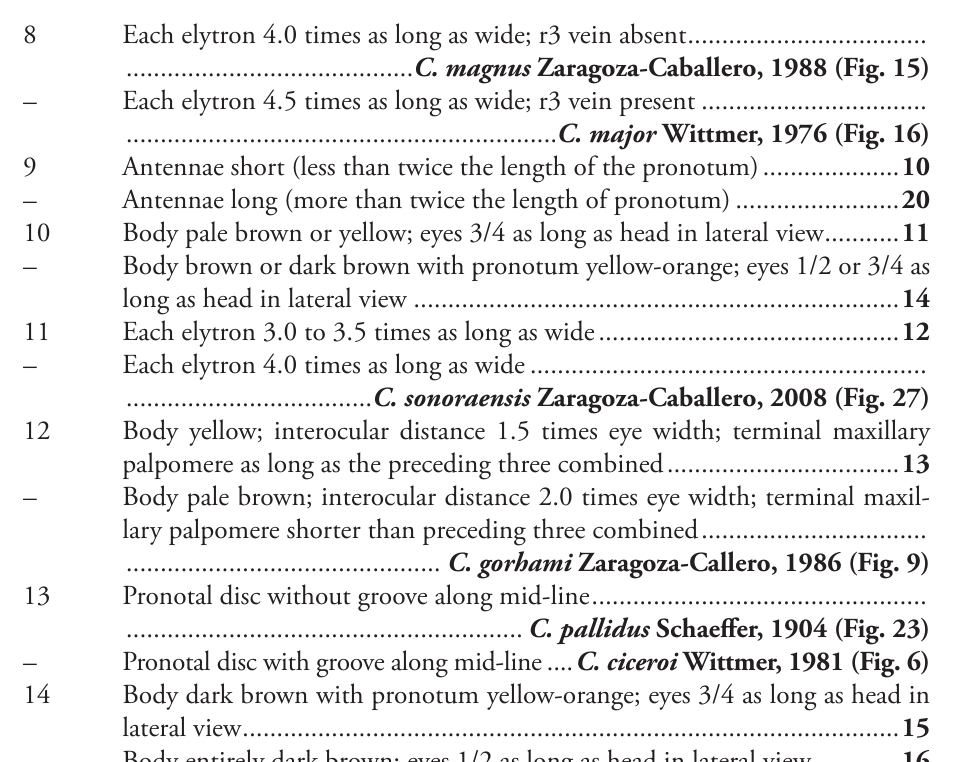
13 – Pronotal disc with groove along mid-line .... C. ciceroi Wittmer, 1981 (Fig. 6) 14 Body dark brown with pronotum yellow-orange; eyes 3/4 as long as head in – Body entirely dark brown; eyes 1/2 as long as head in lateral view ............ 16 15 Interocular distance twice as long as eye width (Fig. 13C); antennomere 1 long- er than next two combined ........ C. kikapu Vega-Badillo et al. 2021 (Fig. 13) – Interocular distance 3.5 times eye width (Fig. 14C); antennomere 1, 1.7 times longer than next two combined ........ C. longicollis Wittmer, 1976 (Fig. 14) 16 Interocular distance 2.5 times width of eye; 4 th (terminal) maxillary pal-